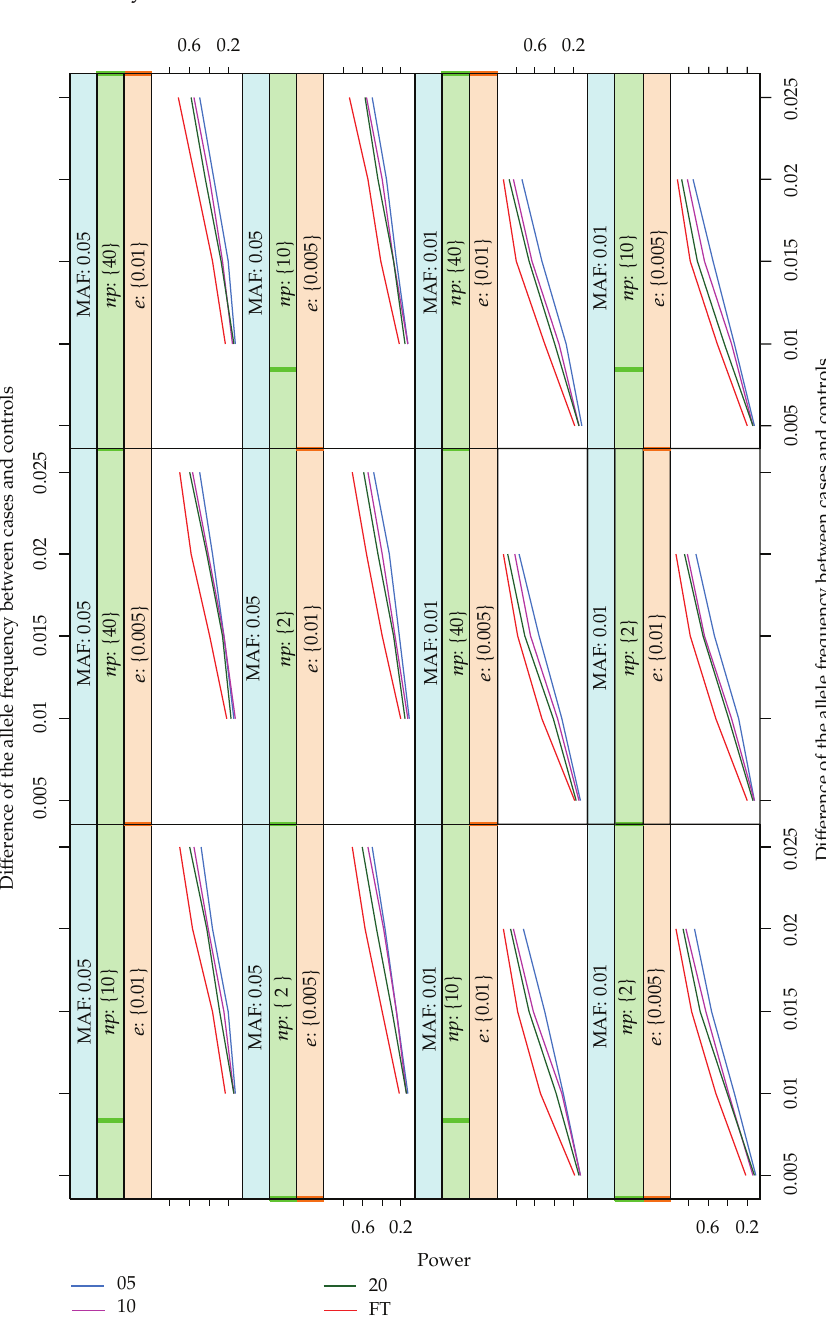
Figure 1: Empirical power at the a level of 5% for the parametric bootstrap (cid:2) PB (cid:3) test as a function of the di ff erence of the allele frequency between cases and controls under various sequencing error rates, numbers of pools, and depths of sequencing coverage for testing association. Sample size was set at 500 cases and 500 controls. The minor allele frequencies (cid:2) MAF (cid:3) of controls were set at 0.01 and 0.5, sequencing error rates (cid:2) e (cid:3) were set at 0.005 and 0.01; and numbers of pools were set at 2, 10, and 40. Lines with di ff erent colors indicate the power of the PB test under di ff erent depths of coverage, which are compared to that of the Fisher’s exact test (cid:2) read line (cid:3) based on the true individual genotypes (cid:2) FT (cid:3)